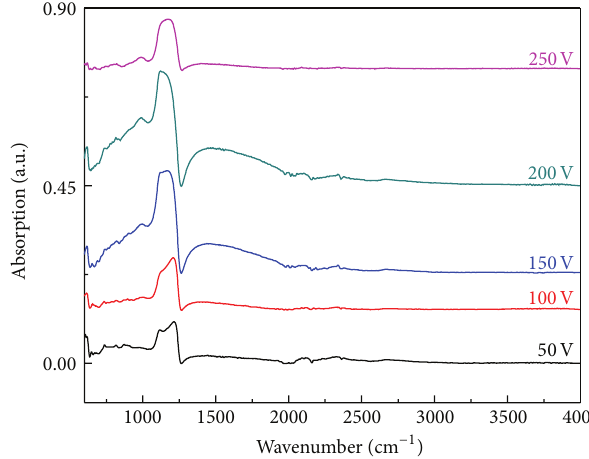
Figure 4: FTIR absorption spectra of oxide films developed under potentiostatic mode at different voltages from 50 to 250